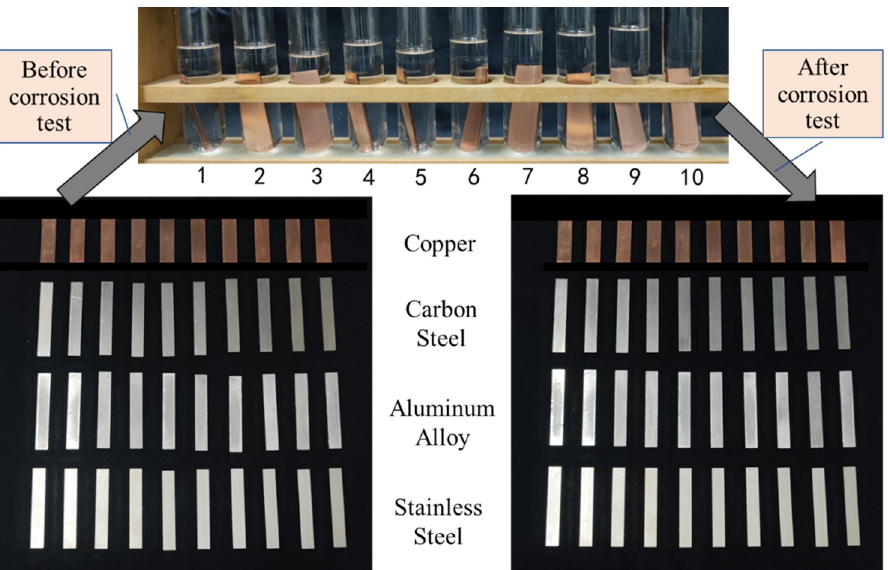
Figure 5. Sheet metal corrosion effects (copper, carbon steel, aluminium alloy, and stainless steel before and after immersion in fuel; tube 1 is pure methanol, tube 10 is pure glycerol, and the volume ratio of glycerol in tubes 2–9 were 1%, 3%, 5%, 10%, 20%, 30%, 40%, 50%, respectively).